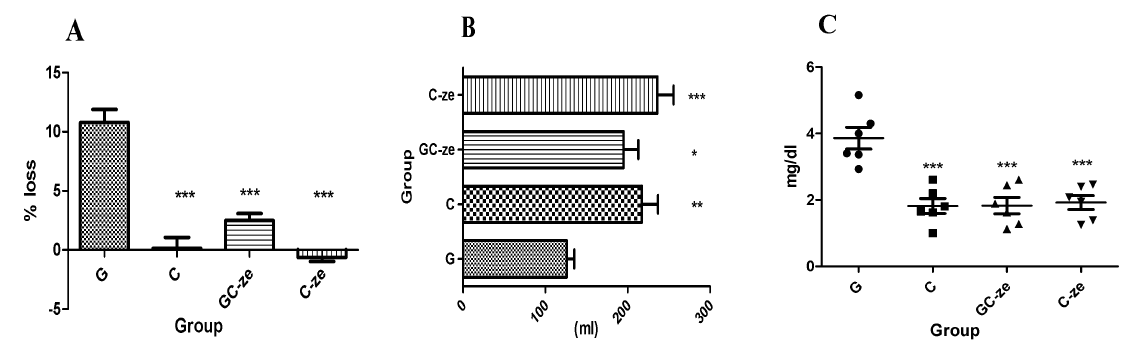
Figure 1: Changes in body weight, urinary volume and urinary protein excretion in various groups. (A) Percent loss in mean body weight in group G animals (gentamicin treated) significantly different from control group, extract treated group and animals treat- ed with both gentamicin and extract. (B) Urinary volume measured on day 21 st presented; Group G significantly different from group GC-ze, very significantly different from group C, and extremely significantly different from group C-ze. (C) Urinary excre- tion of protein on day 21 st significantly different from group C, and other treated groups.